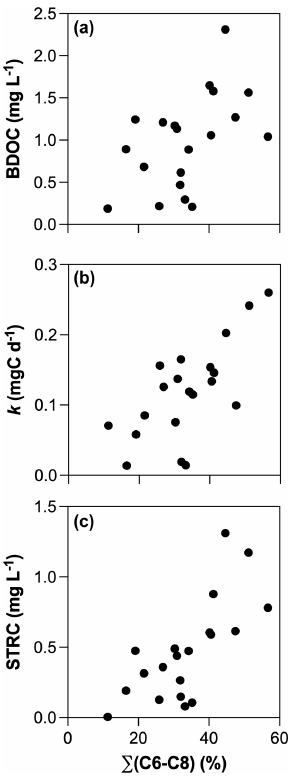
Figure 6. Relationships between (a) BDOC, (b) decay constants and (c) the size of the STRC pools with the sum of initial F Max values of C6, C7, and C8 components.